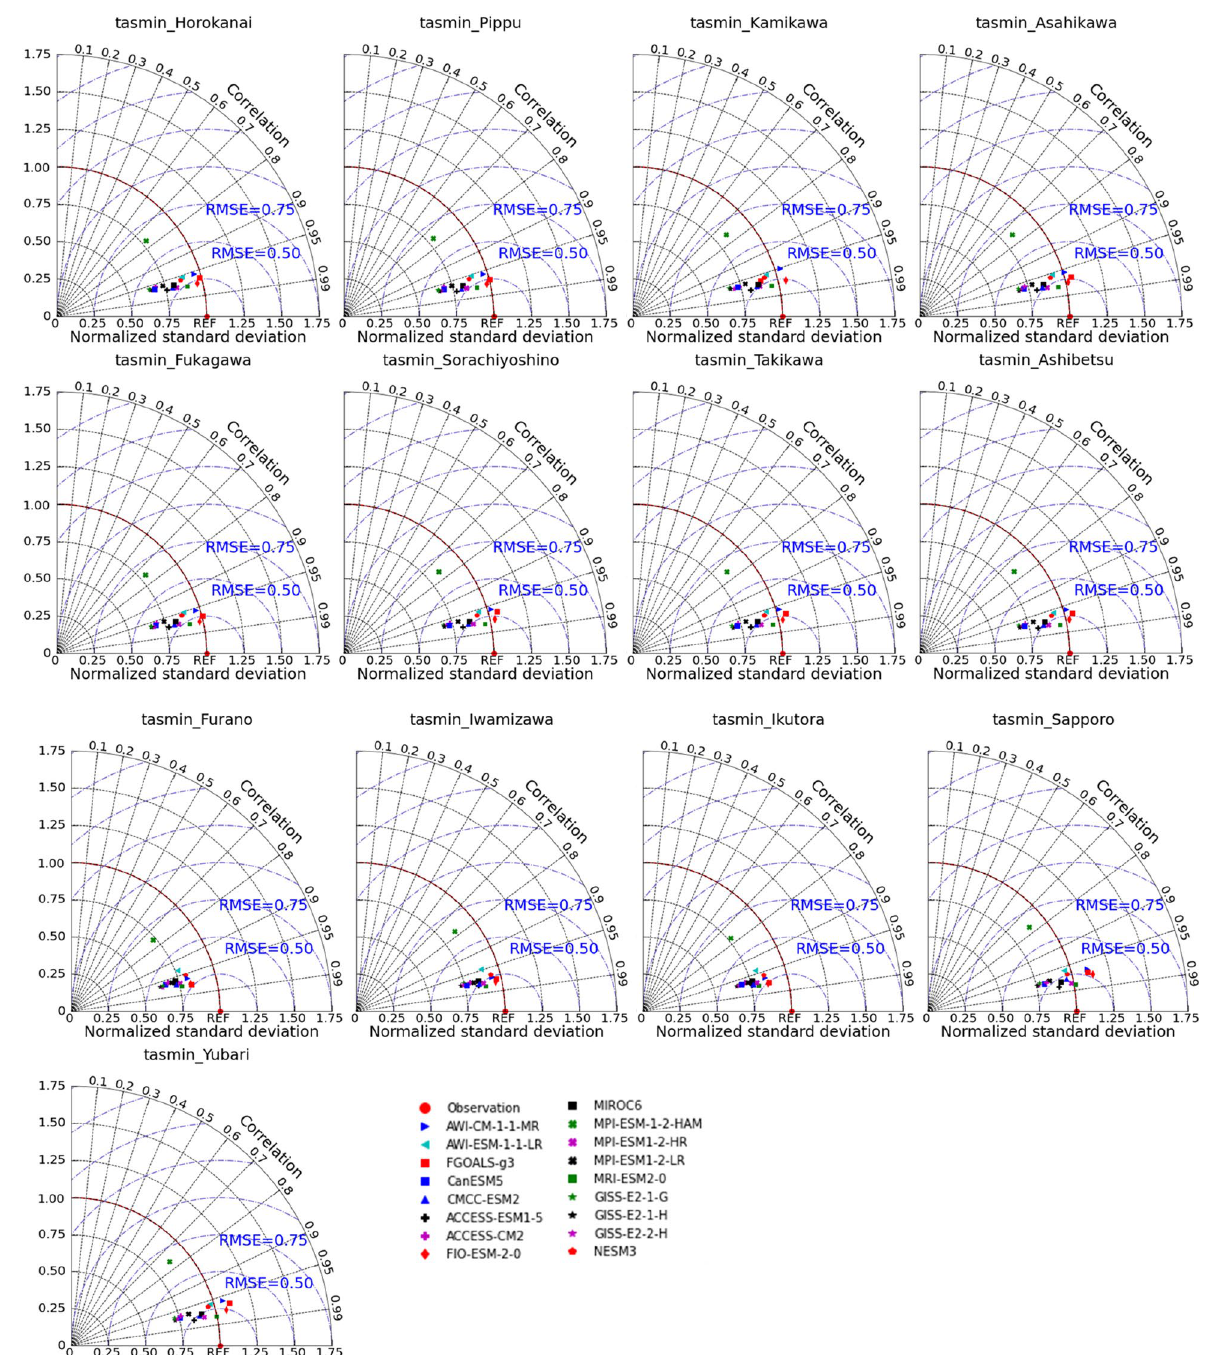
Figure 3. Taylor diagrams of minimum air temperature (tasmin) for each GCM at each